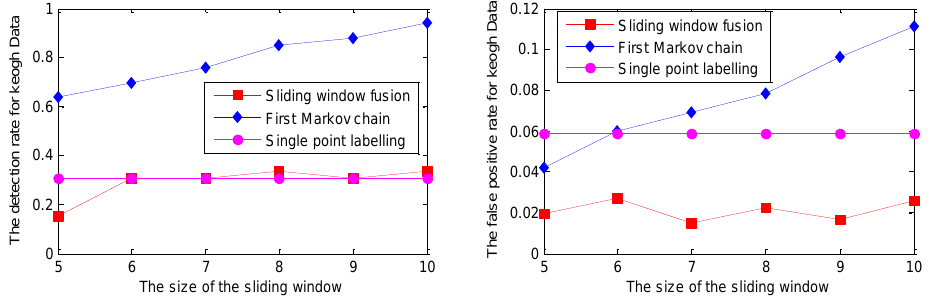
Figure 8. The detection results for one series of the Keogh Data with the relevance vector machine (RVM) model.